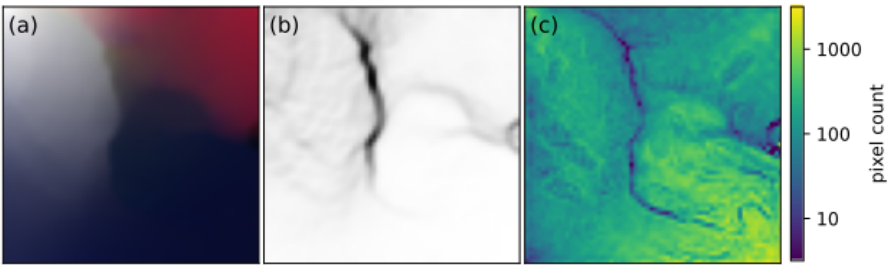
Figure 5. The SOM trained on the first North Sea scene. ( a ) The SOM in false color, represented by bands 816 nm (red), 684 nm (green) and 467 (blue). ( b ) The U-matrix shows the curvature of the surfaces at each node, where darker colors indicate more curvature (arbitrary units). ( c ) The number of pixels in the original image which are classified at each